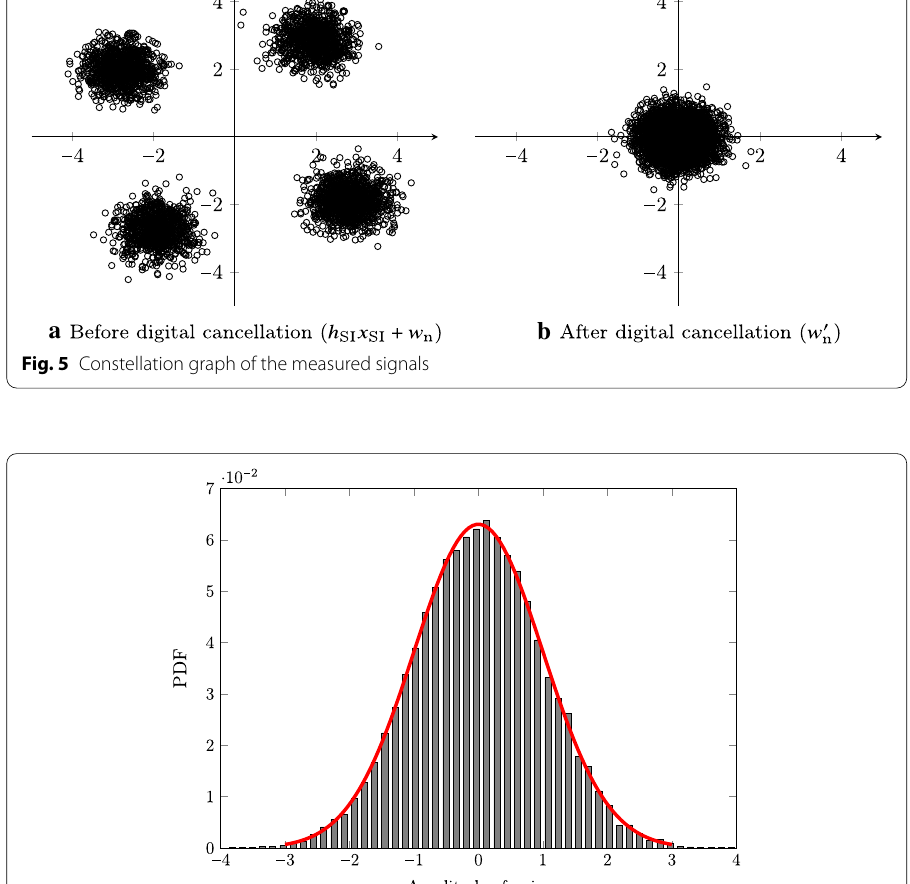
Fig. 6 Histogram of the measured signal after digital cancellation ( w ′ n ) with a Gaussian PDF plotted on